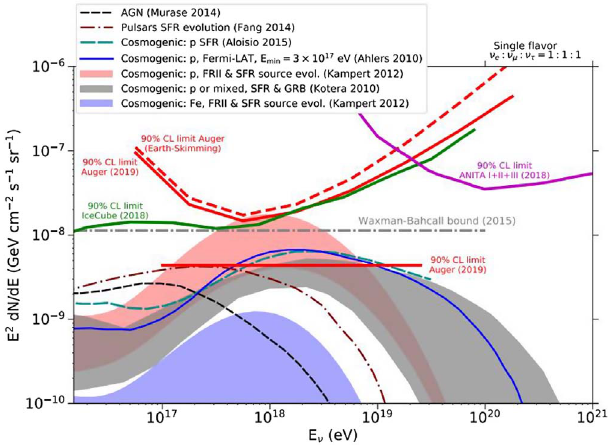
Figure 6. Upper limit to the normalization of the diffuse fl ux of UHE neutrino. The upper limits obtained by the Pierre Auger Observatory are compared to those obtained by IceCube and ANITA, as well as predictions from cosmogenic and astro- physical neutrino production models. Taken from